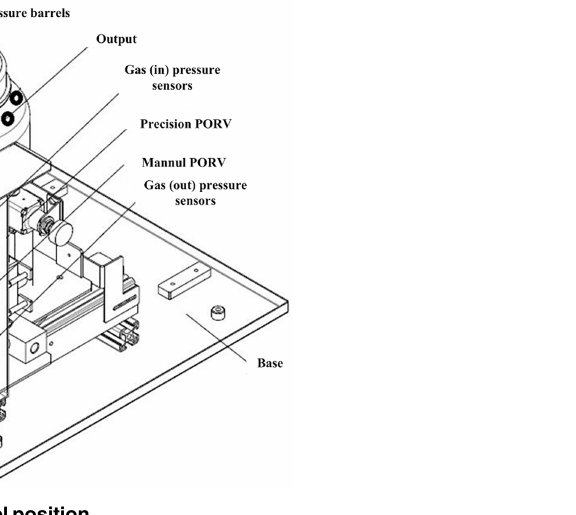
Fig 3. The monitor of liquid level